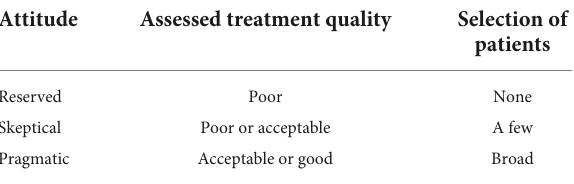
TABLE 3 The correlation between attitude and screening of patients to a video consultation. Attitude Assessed treatment quality Selection of